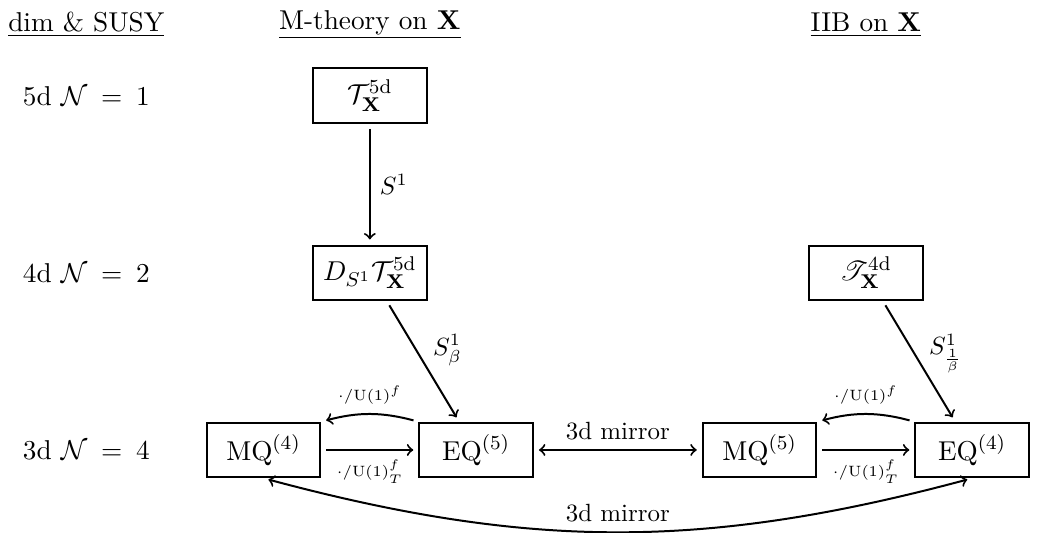
Figure 1 . Summary of the relations between the supersymmetric QFTs in 5d, 4d and 3d associated to a conical threefold singularity X in M-theory and type II string theory. The downward arrows denote dimensional reduction on circles. The 3d N = 4 theories are the ‘quiverines’, which are all related by 3d mirror symmetry and by S-type gauging of U(1) f flavor